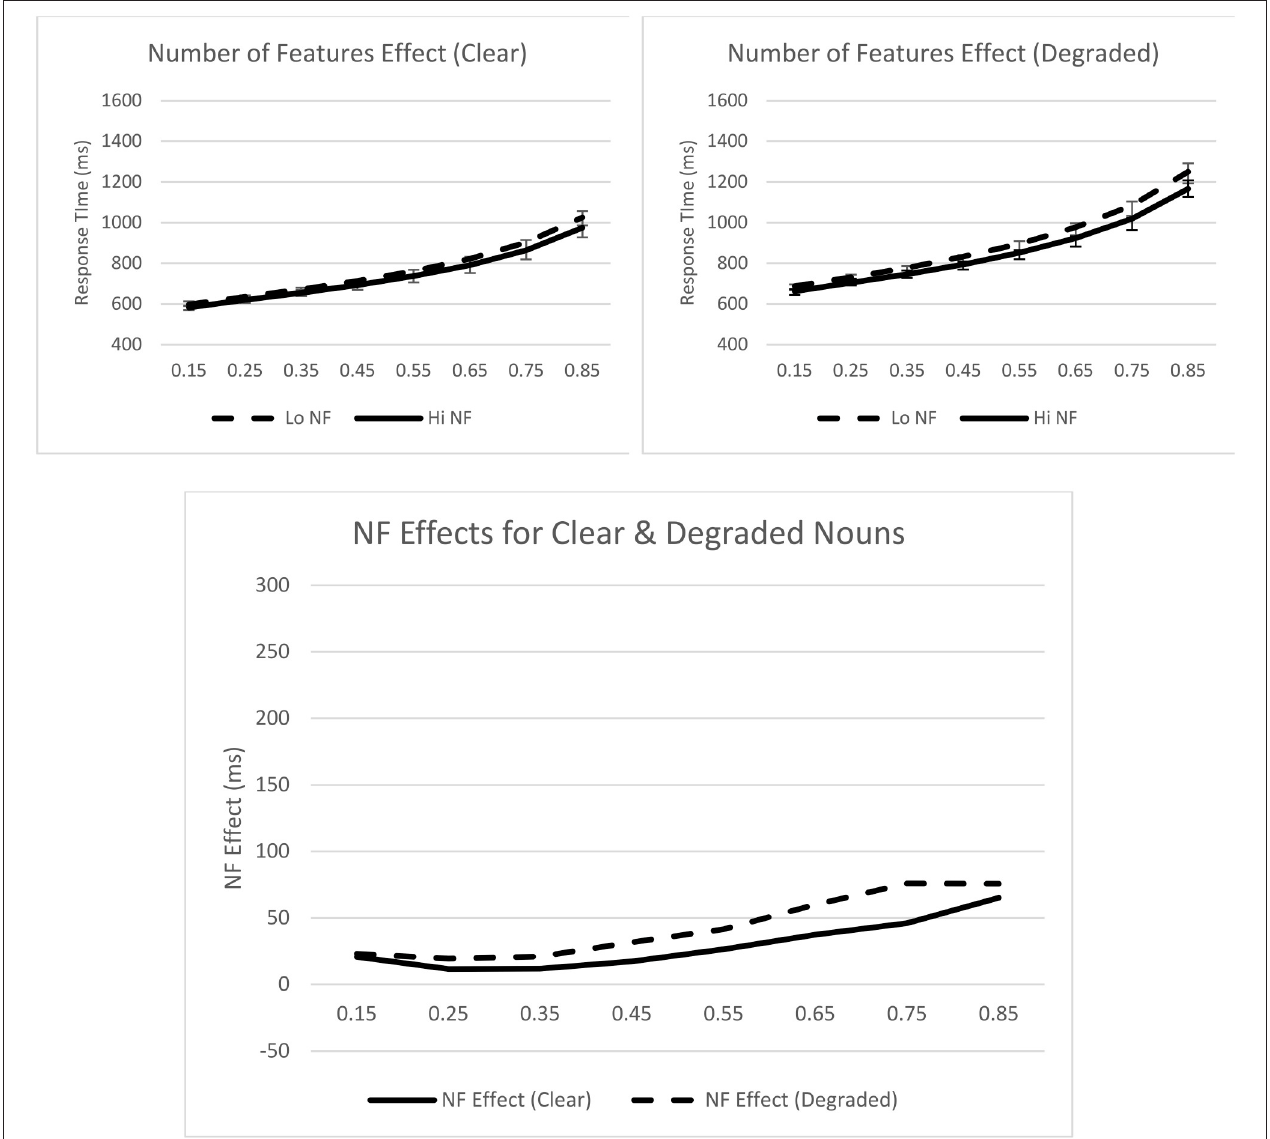
FIGURE 2 | Syntactic classification performance as a function of number of features and quantiles for clear (top left panel) and degraded (top right panel) words. Empirical quantiles are represented by error bars, whereas fitted ex-Gaussian quantiles are represented by lines. The bottom panel shows number of feature effects as a function of stimulus quality. NF, number of features.